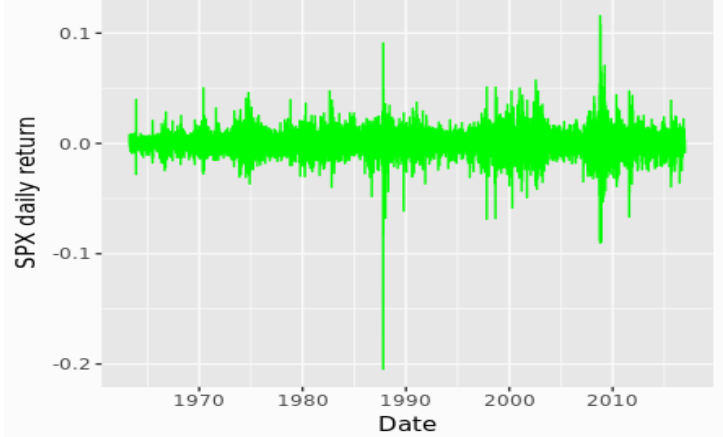
Figure 6. Daily S&P 500 index returns from